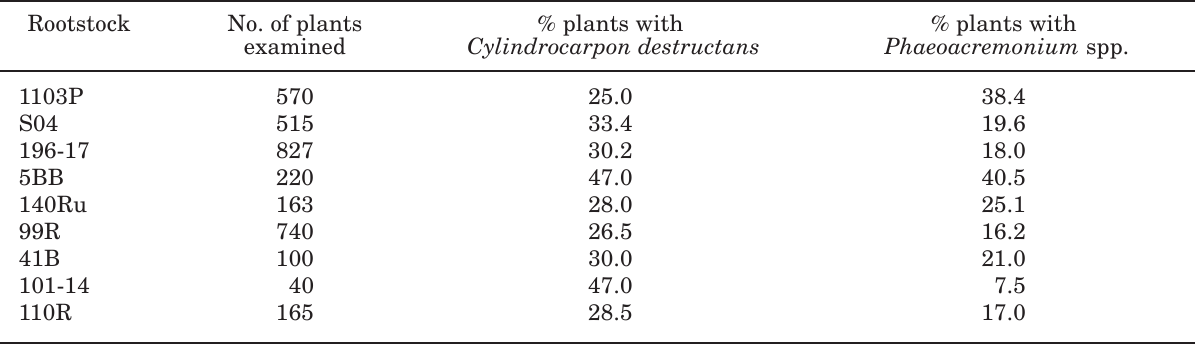
Table 1. Frequency of isolation of Cylindrocarpon destructans and Phaeoacremonium spp . from nine different root- stocks. Rootstock No. of plants % plants with % plants with examined Cylindrocarpon destructans Phaeoacremonium spp.